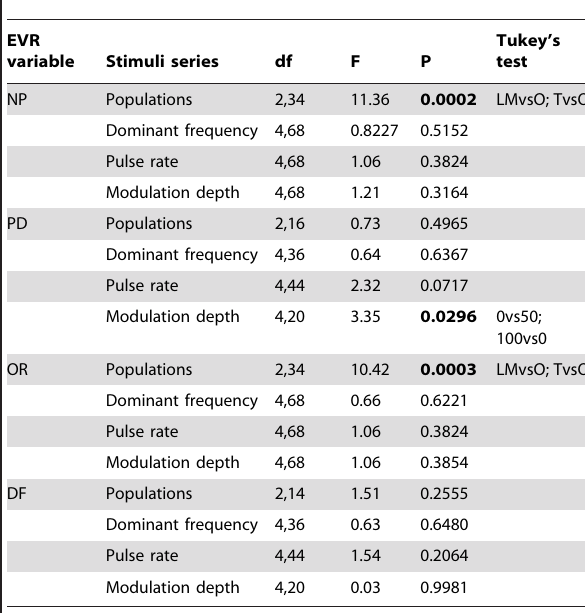
Table 4. Repeated measures GLMs and Tukey’s test for EVR variables (NP, DP, OR and DF) within four series of stimuli presented to males from the Los Maitenes population of P. thaul .